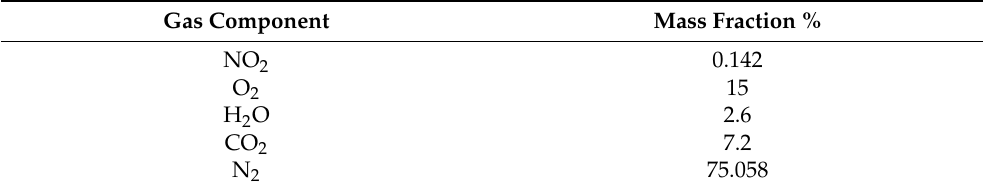
Table 2. Euro 5 diesel gas components and mass